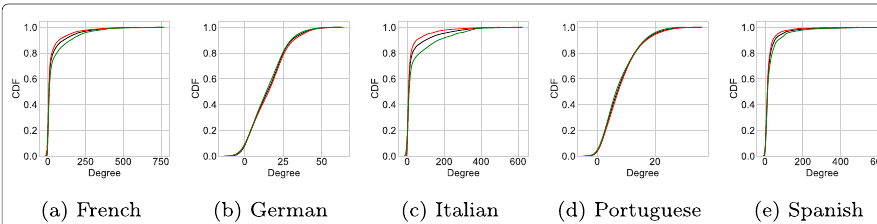
Fig. 9 Degree Distributions. This figure depicts the CDF of degrees of all nodes (black lines), positive nodes (green lines) and negative nodes (red lines) respectively for each of the five languages contained in our dataset. In case of the three larger networks, including French (cf. Fig. 9a), Italian (cf. Fig. 9c) and Spanish (cf. Fig. 9e), negative nodes have higher probability for low degrees whereas positive nodes have higher probability for mid-range degrees. The difference between degree distributions of positive and negative words is significant ( p -values < 0.0005) for each of the three networks according to two-sample Kolmogorov-Smirnov tests. Results are different for the two smaller German (cf. Fig. 9b) and Portuguese networks (cf. Fig. 9d) for which there is no significant difference between positive and negative distributions according to a two-sample Kolmogorov-Smirnov test ( p -values >